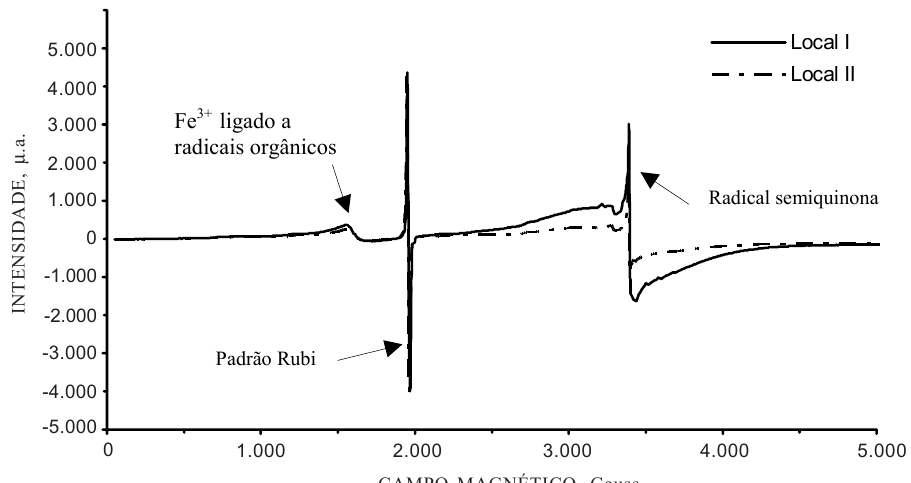
CAMPO MAGNÉTICO, Figura 4. Espectro de RPE das amostras sólidas de AH, extraído da camada de 0,00–0,10 m, dos locais I e II, depois da centrifugação de 12.500 rpm por 3 h. I = intensidade.